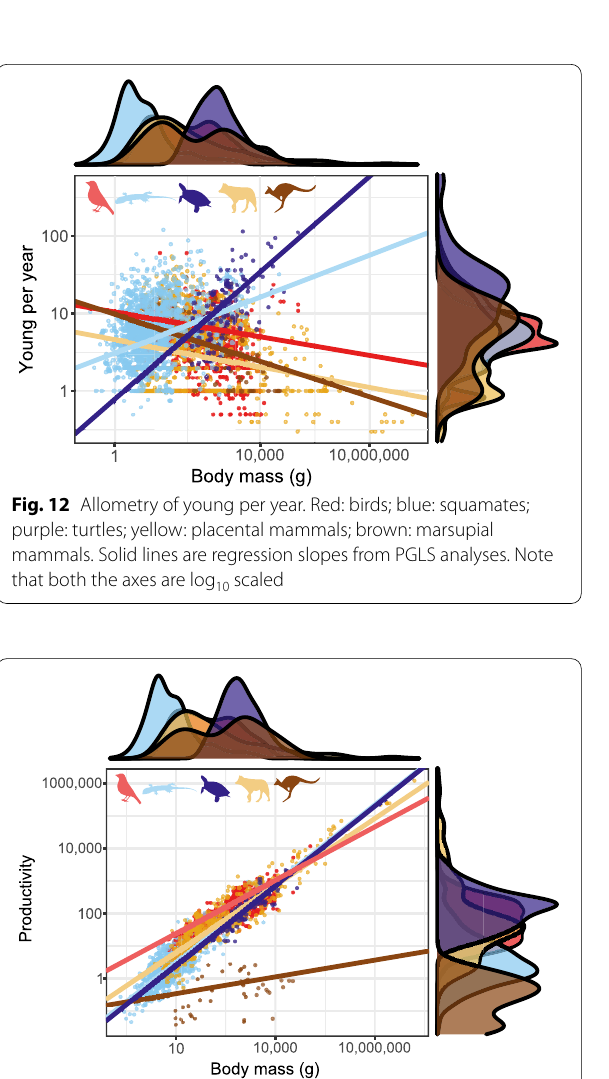
Fig. 13 Allometry of yearly biomass productivity of amniotes. Red: birds; blue: squamates; purple: turtles; yellow: placental mammals; brown: marsupial mammals. Solid lines are regression slopes from PGLS analyses. Both axes are in log 10